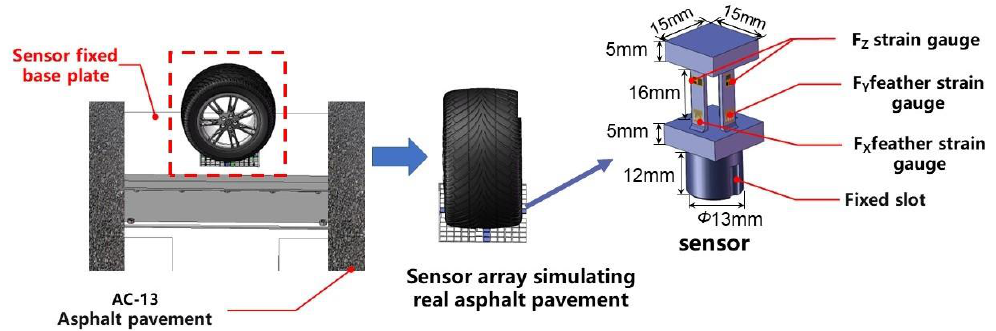
Figure 2. Sensor structure and assembly